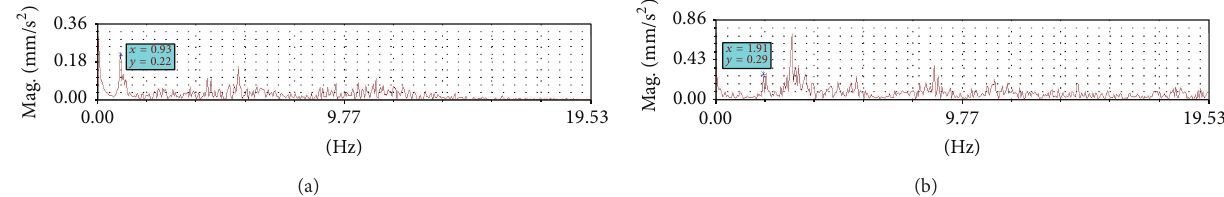
Figure11:PowerspectrumsoftheaccelerationresponsesinthespanofS006-S007:(a)longitudinalbridgedirectionand(b)verticaldirection.